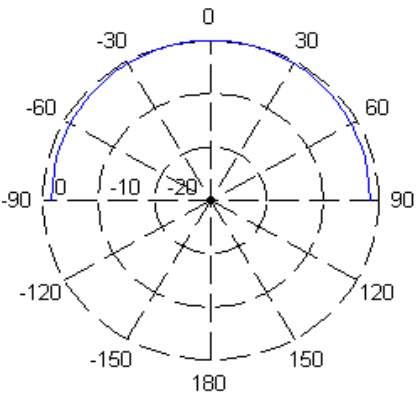
Figure 3. Directivity diagram of micro vibration unit.